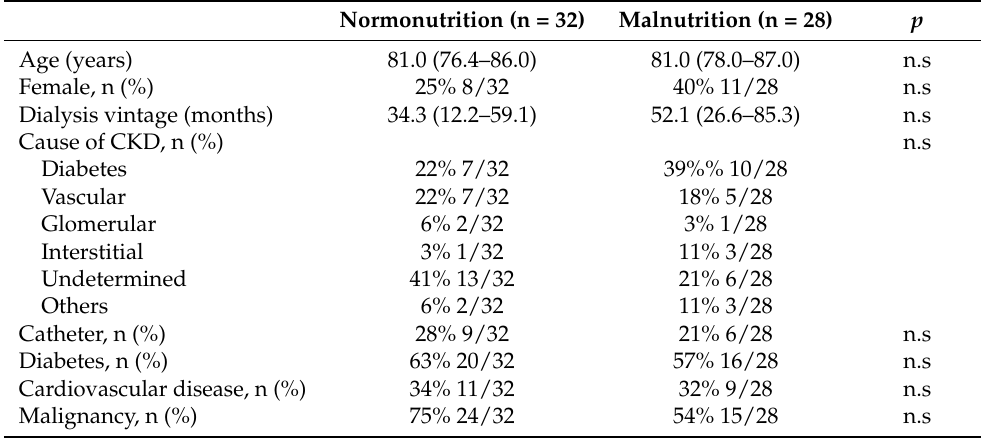
Table 2. Analytical, clinical, body composition and nutrition data of participants with normonutrition or malnutrition according to the MIS (malnourished if >5